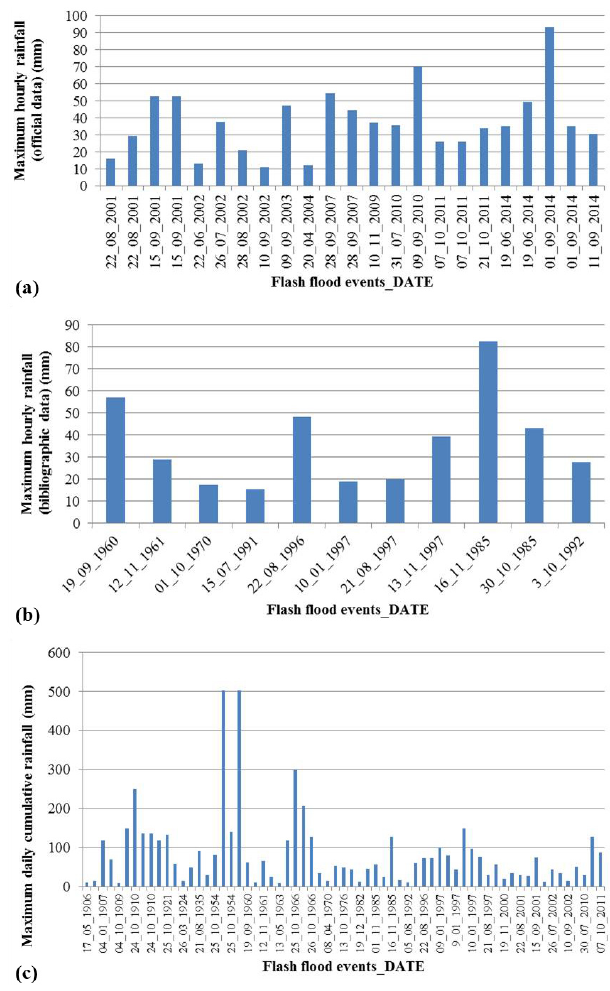
Figure 3. Rainfall data associated to flash floods: (a) maximum hourly rainfall (official data from CFDC); (b) maximum hourly rainfall (data from the literature); (c) maximum daily cumulative rainfall (data from SIMN).